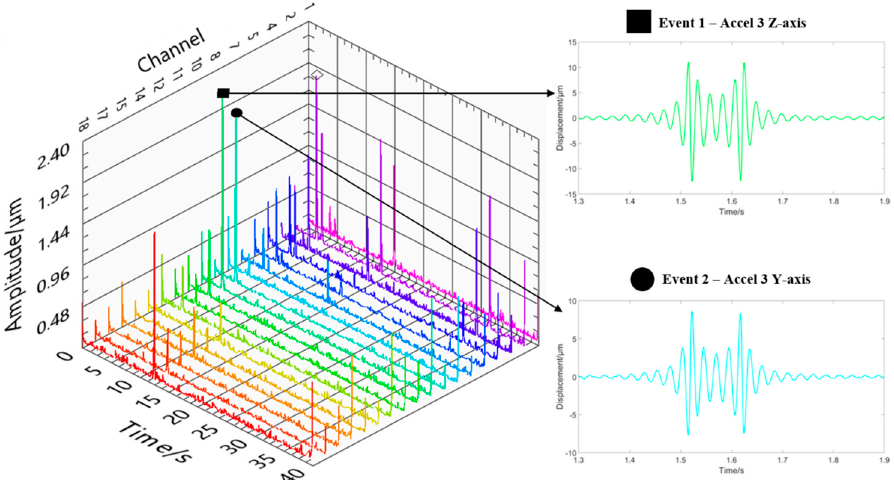
Figure 9. 3D stacked ribbon plot of the displacement envelope results for all 18 measurement signals ( x , y and z axes for each accelerometer) with the key events that are identified to be of interest and so further